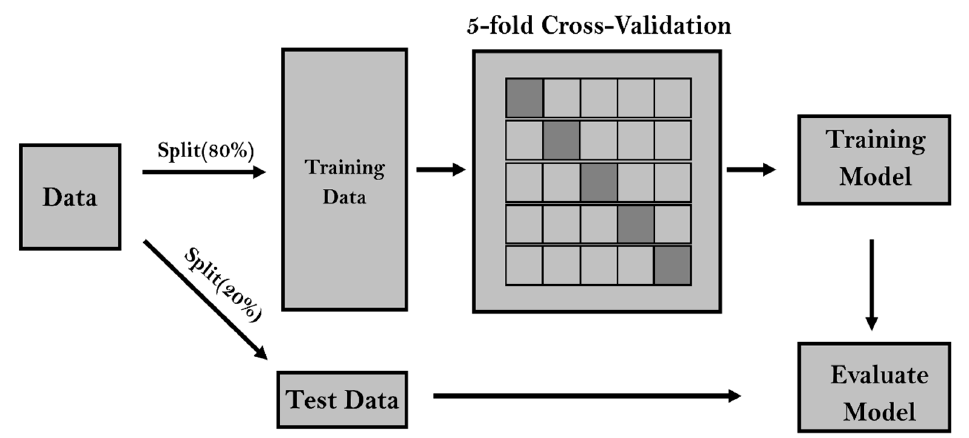
Figure 5. The flowchart of the research methodology workflow.